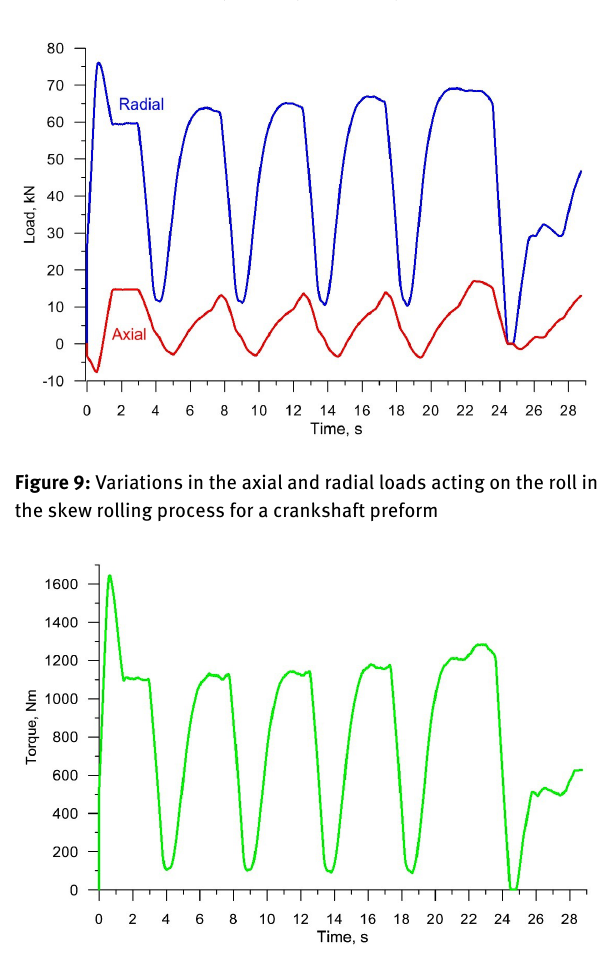
values of the loads acting on the roll (both axial and radial) depend on the changes in the workpiece